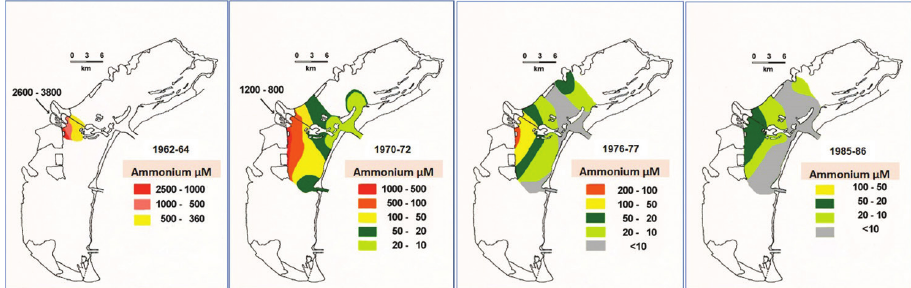
Figure 5. Distribution of ammonium in the water column in the central lagoon from 1962 to 1986 (from Cossu and De Fraja-Frangipane 1985).